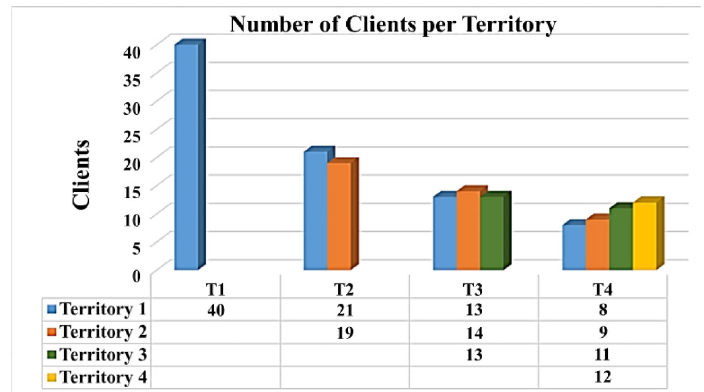
Figure 2. Graph of client distribution in each